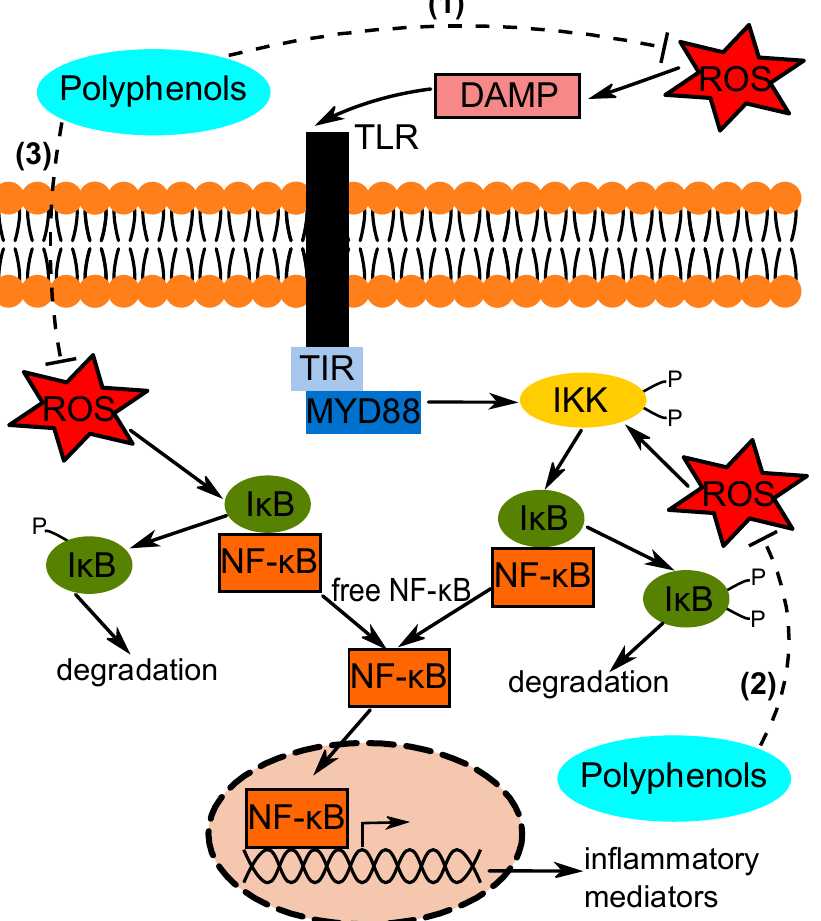
Figure 1. Potential mechanism of action of polyphenols in inflammation inhibition. Polyphenols may target the reactive oxygen species (ROS) to reduce oxidative stress. (1) ROS reduction could reduce the amount of damage-associated molecular patterns (DAMPs); (2) ROS reduction could also arrest the phosphorylation of I κ B kinase (IKK), which would block the dissociation of I κ B from NF- κ B; (3) ROS could directly phosphorylate I κ B, which could be prevented by polyphenols. These pathways would inhibit nuclear translocation of NF- κ B.